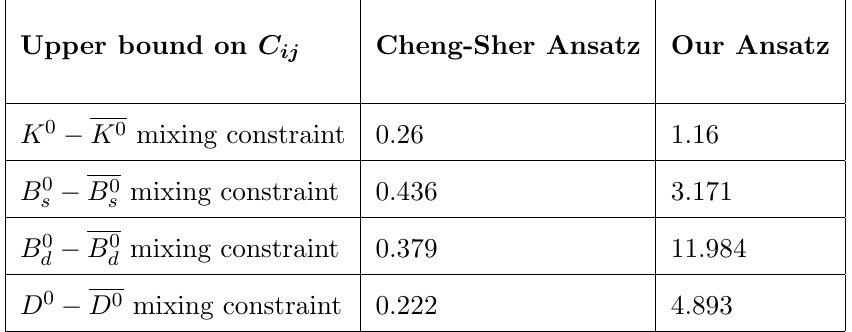
(cid:0) B 0 , B 0 (cid:0) B 0 and D 0 (cid:0) D 0 s s d d